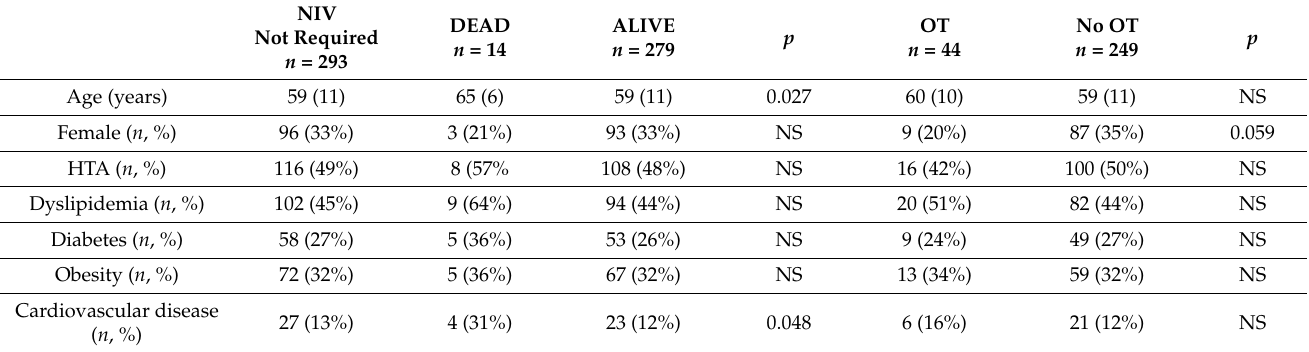
Table 3. Characteristics depending on survival and intubation status in the non-NIV group: patients with moderate hypoxemic respiratory. OT, oral intubation; HTA, arterial systemic hypertension; OSA, obstructive sleep apnea; COPD chronic obstructive pulmonary disease; IS therapy, immuno- suppressive therapy; IRCU, intermediate respiratory care unit; ICU, intensive care unit; SaFiO 2 , oxygen saturation by pulse oximetry divided by inspired oxygen fraction; PaFiO 2 , partial arterial pressure of oxygen divided by inspired oxygen fraction; LDH, lactate dehydrogenase; RR, respiratory rate; PaCO 2 : partial arterial pressure of carbon dioxide; NRT, non-invasive respiratory therapy; HFNC, high flow nasal cannula; NIV, non-invasive ventilation; FiO 2 , inspired oxygen fraction;